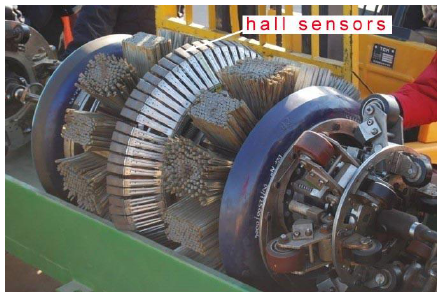
Figure 10. Photo of the magnetic pig with the Hall sensors.